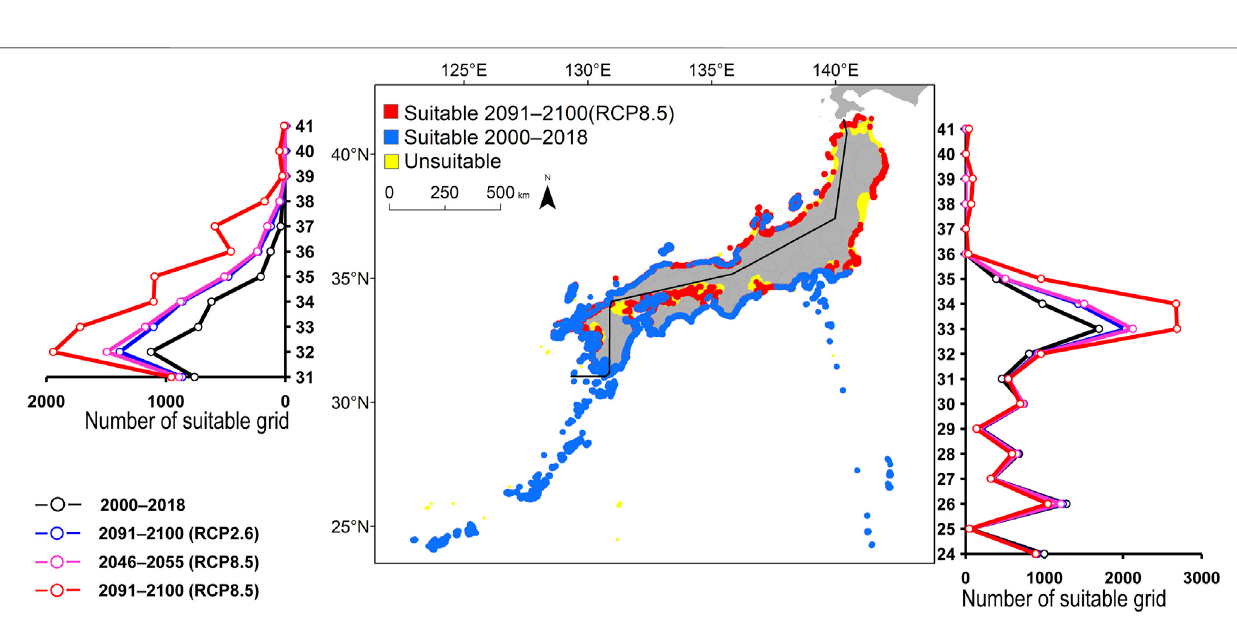
Frontiers in Built Environment |